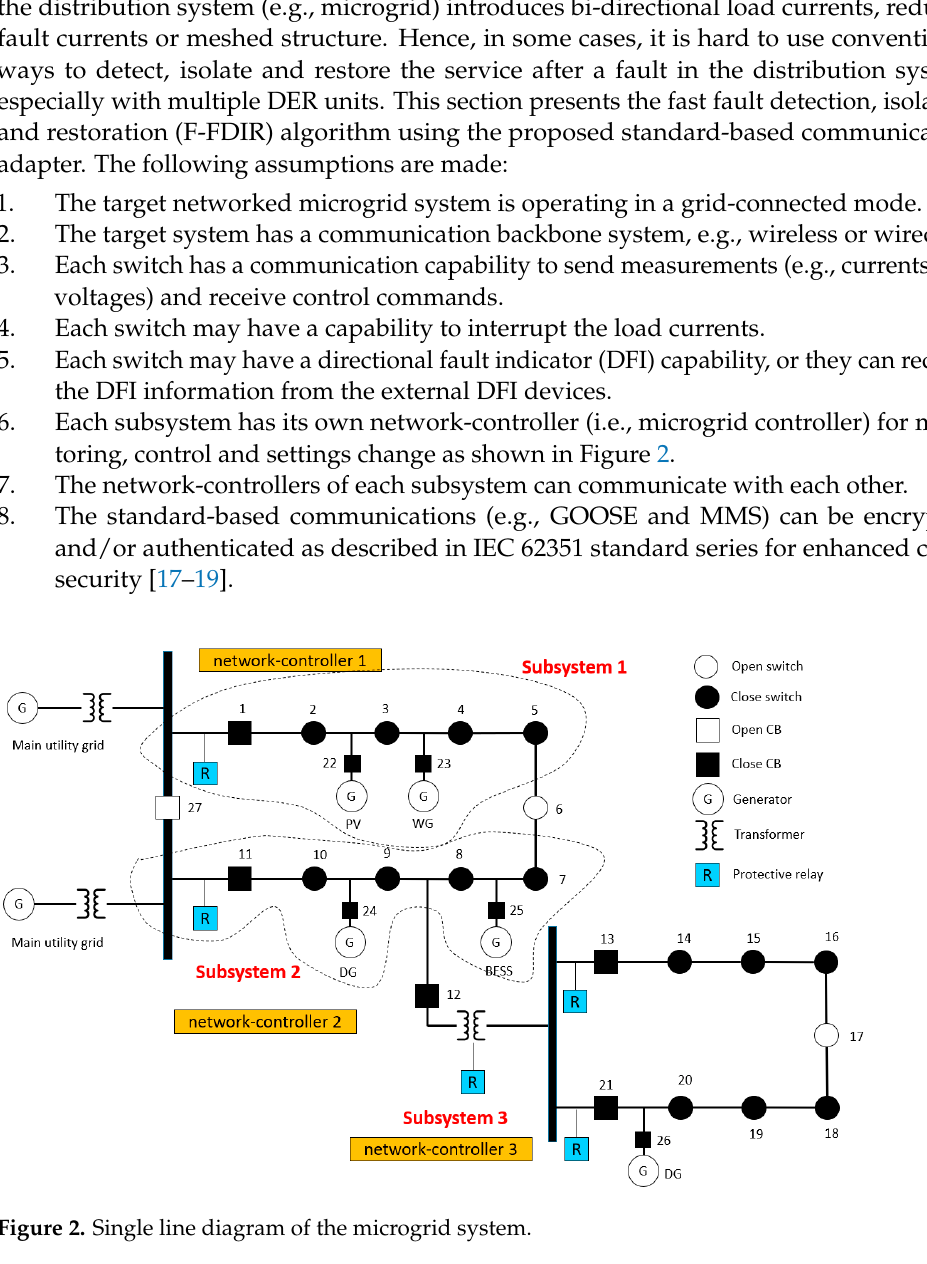
POI CB Figure 3. Examples of possible combination of directional fault indicators (DFIs) for the microgrid feeder.